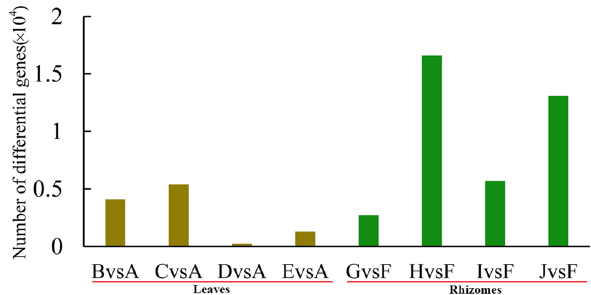
Figure 2. The number of DEGs from samples of leaf and rhizome at each treatment time point compared with the control (The A-E indicates the ‘Little Dream’ of leaves under stress at 0, 6, 12, 24, and 48 h, respectively, the F-J were ‘Little Dream’ of rhizomes under stress at the same time points).